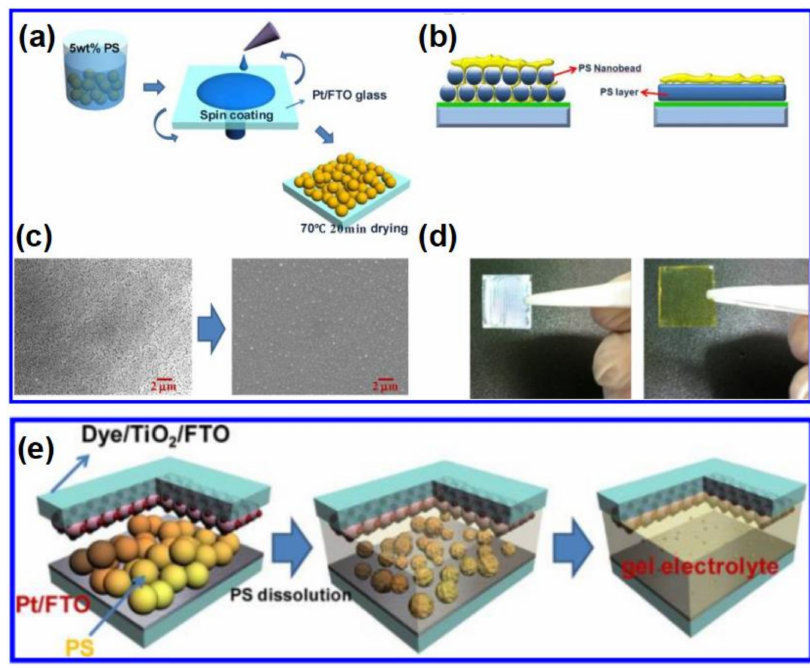
Figure 5. ( a ) Preparation schematic of PS nanobeads on FTO / Pt substrate; ( b ) Comparison schematic of the pore-filling before (left) and after (right) dissolving the PS nanobeads; ( c and d ) FESEM images andphotographsofthePSnanobeadsontheFTO / Ptsubstratebefore(left)andafter(right)thedissolution process; ( e ) Conversion schematic of liquid electrolyte to gel electrolyte by using valeronitrile solvent to dissolve the PS nanobeads (reproduced from Reference [123] with permission, copyright American Chemical Society,